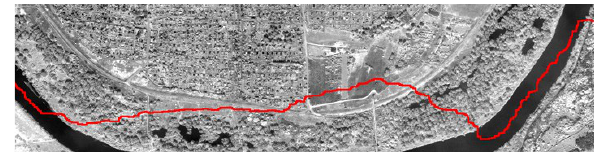
Figure 10. An example of routing the seamlines in a satellite orthoimage